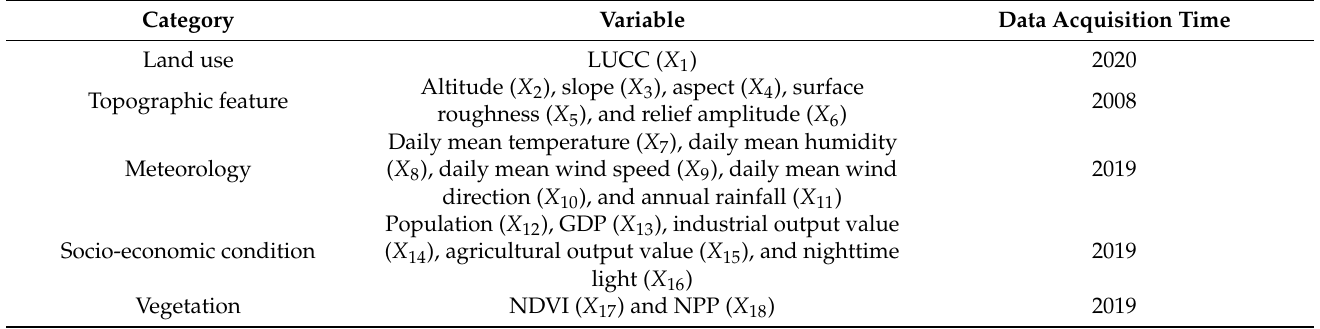
Table 1. List of variables